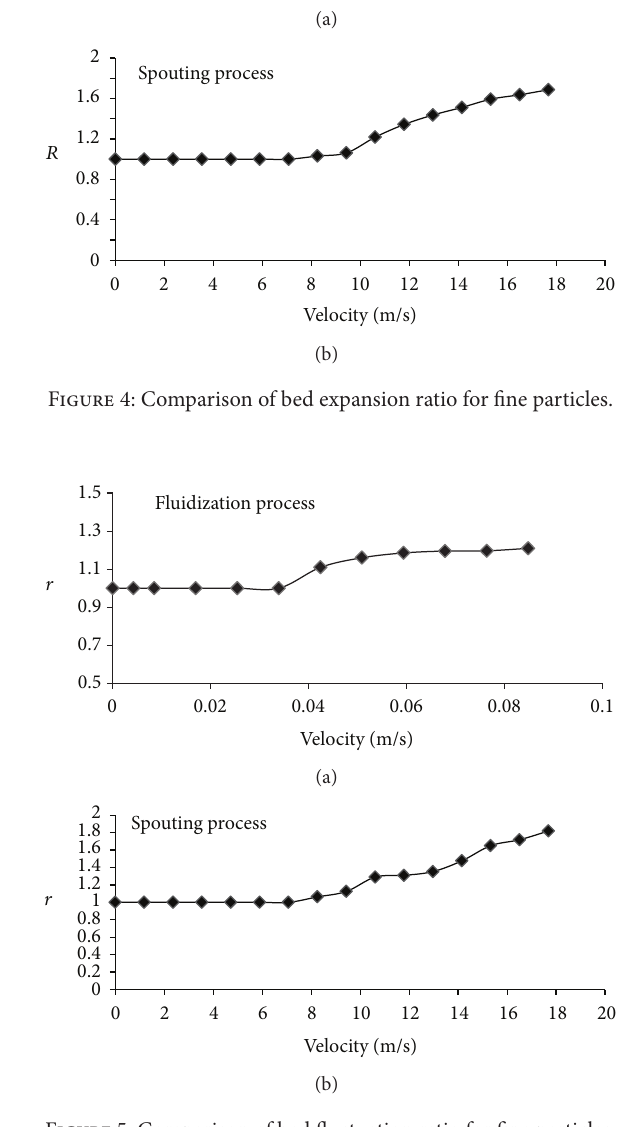
Figure 5: Comparison of bed fluctuation ratio for fine